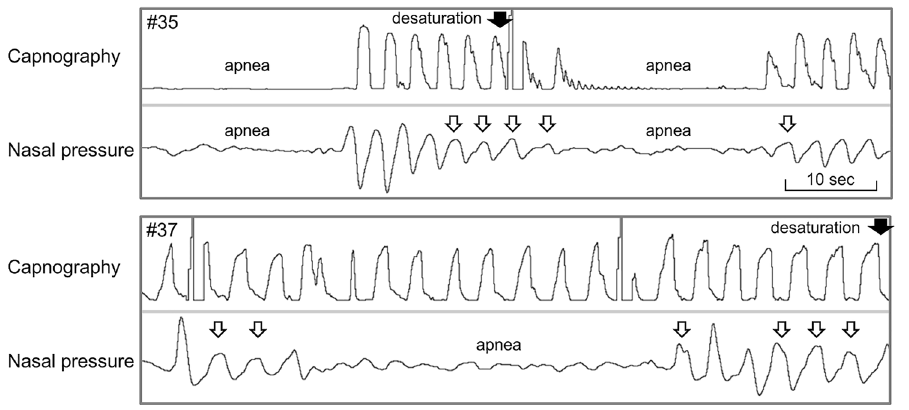
Figure 2. Waveform examples. Top, capnography; bottom, nasal pressure monitoring. Arrows (black) indicate the point of SpO 2 < 90% in Patient #35 and SpO 2 < 95% in Patient #37. Arrows (white) indicate obstructive respiratory disorder, revealing a flattened waveform pattern. No desaturation occurred after the second short period of apnea in patients